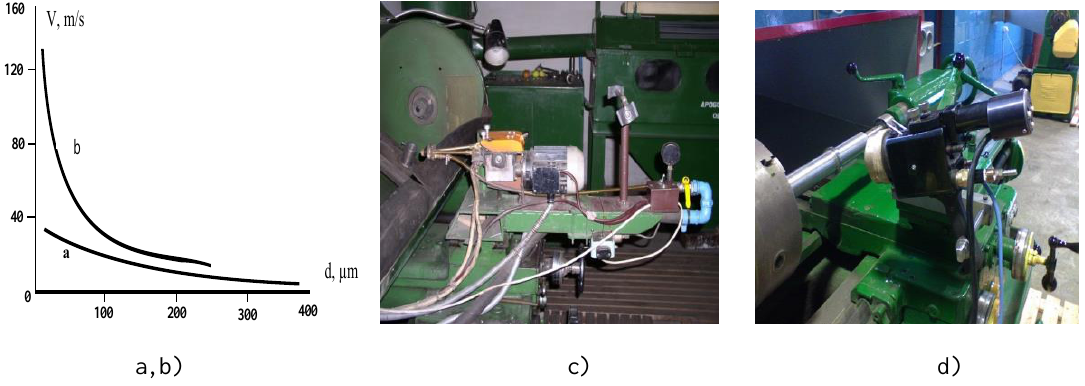
Fig. 1. Dependence of the velocity of metal particles on their size for different modes of metal-air flow formation (a, b): central nozzle scheme (а) and closed scheme (b) ; apparatus EM-14 for electric arc spraying